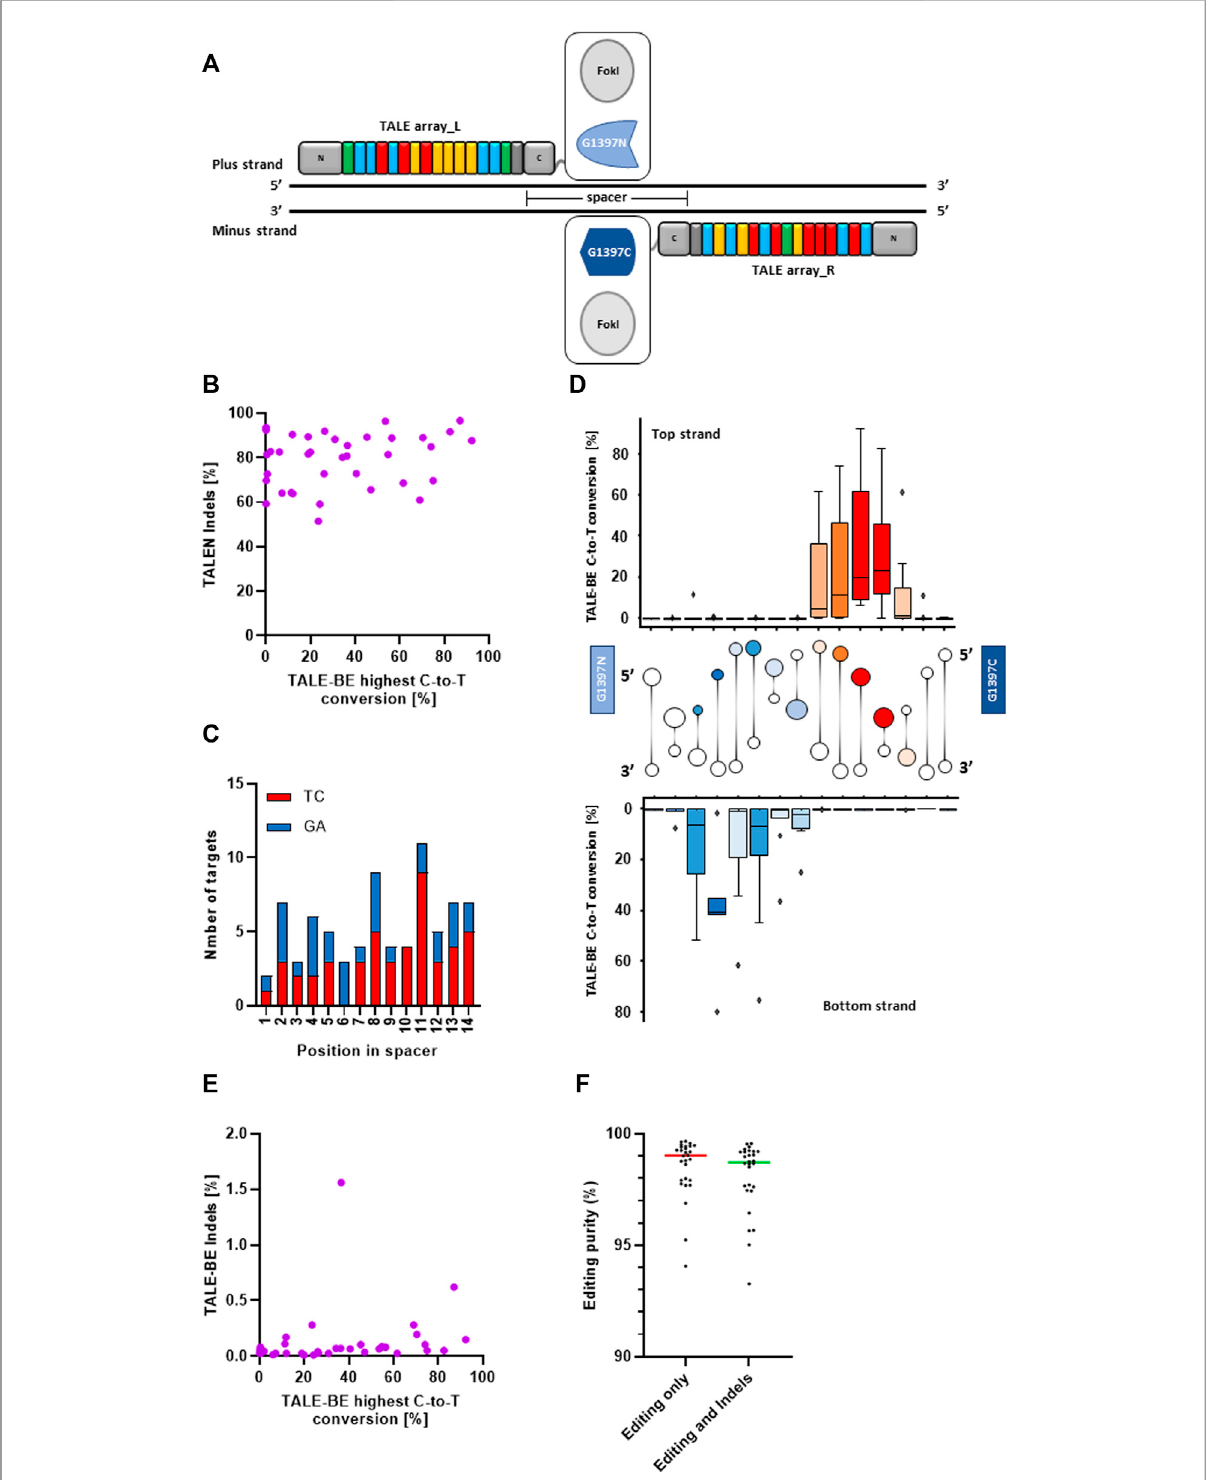
FIGURE 1 (A). Schematic representation of a TALEN and a TALE-BE. (B). Average of the highest C-to-T conversion frequencies of 37 base editors (among alleditedbaseswithin thetarget spacer region)versusthefrequencies ofindelscreatedbythematchingTALEN ( N =2, independent T-cellsdonors). (C). RepartitionofTC/GAinthespacerofthe37TALE-BE. (D). C-to-TconversionfrequenciesofthetargetC(top)orG(bottom)atdifferentpositions within the 15 bp TALE-BE spacer (box represent 5% – 95% percentile, whiskers represent min and max) with cartoon of DNA double helix